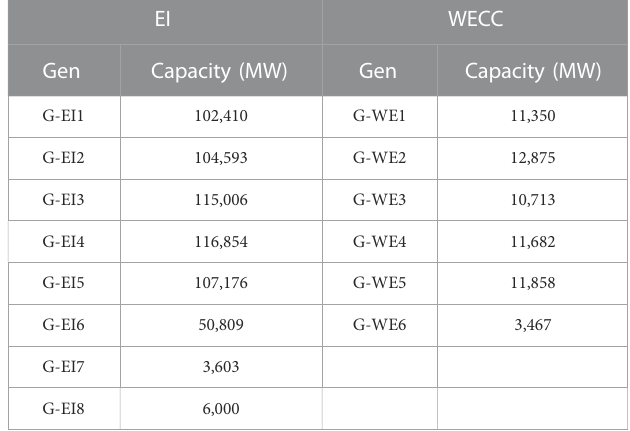
TABLE 1 Generation capacities of the highly NAG